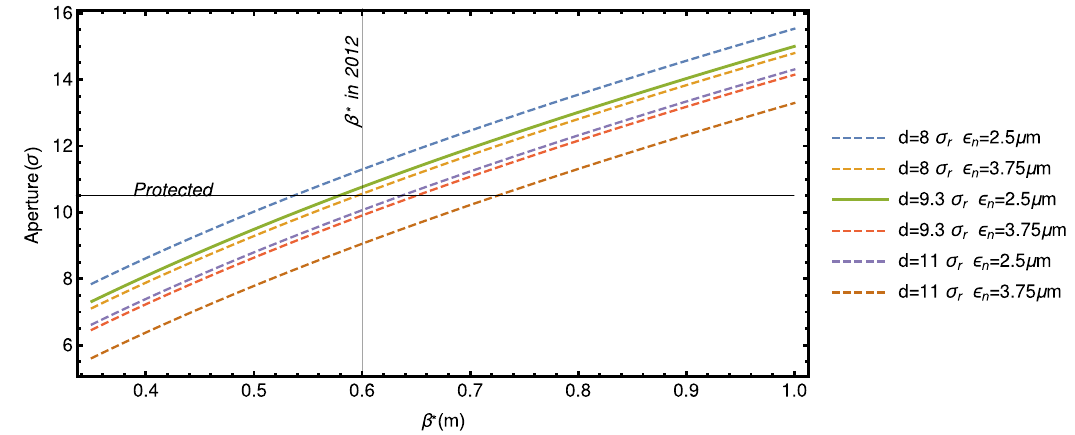
FIG. 5. Calculated triplet aperture, for 4 TeV proton beams with 3 . 5 μ m in the LHC, as a function of β (cid:1) for different values of the beam-beam separation d , where d ¼ 9 . 3 σ r with the assumption of ϵ n ¼ 2 . 5 μ m, was used in LHC operation during the last part of Run I. The calculation was carried out based on Eq. (13) and the measured aperture in 2011. The crossing angle varies along the